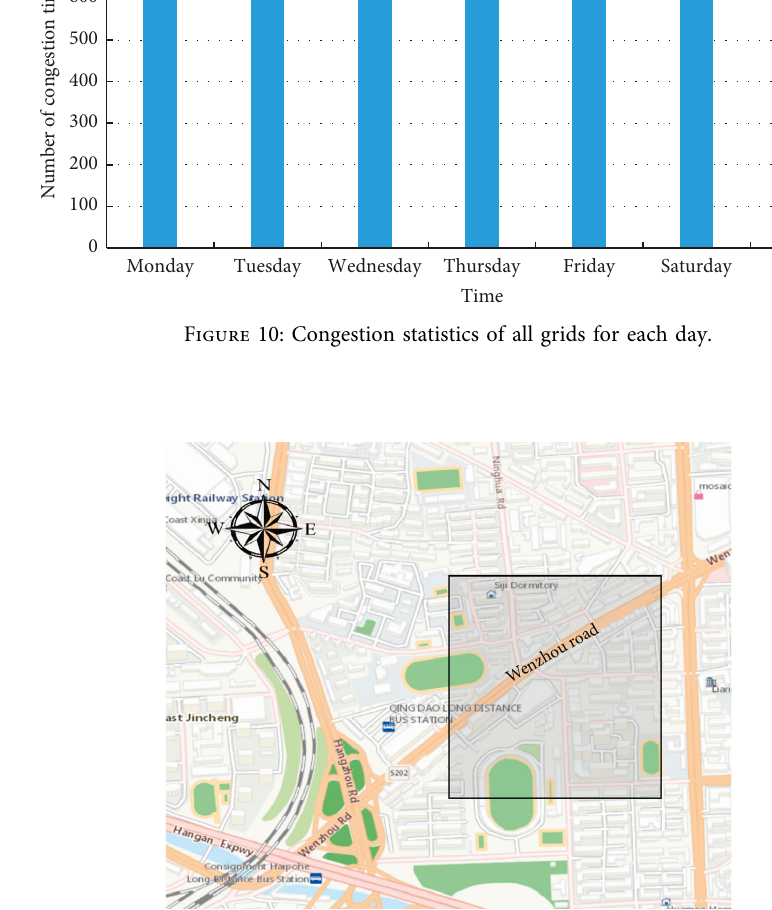
Figure 11: Road distribution of grid (1,